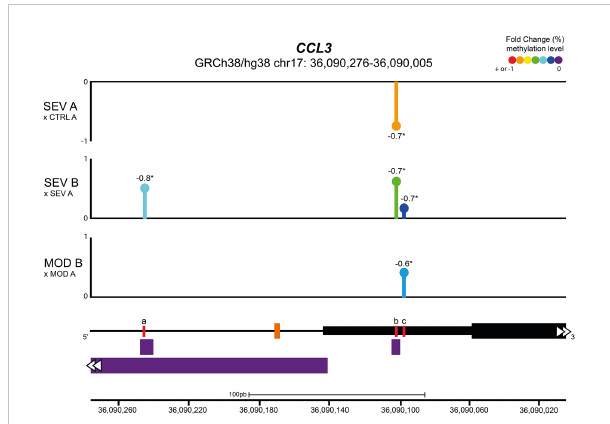
FIGURE 4 Vitamin B12 increased methylation levels of CpGs in regulatory regions of CCL3. Lollipop plot depicting the percent fold change of methylation levels of CpG sites in the promoter region and proximal portion of the fi rst exon of the CCL3 gene. Values next to lollipops represent correlation coef fi cients (Pearson or Spearman) with statistical signi fi cance (* P < 0.05) between methylation levels in each CpG position and gene expression values. The % fold change of methylation levels of CpG positions were compared pairwise using two-tailed Mann-Whitney. N sample = MOD (5) and SEV (5) for each endpoint (A or B), CTRL (5). In the schematic representation of the analyzed gene region, the black line represents the CCL3 promoter region and the black blocks delimit the 5 ’ UTR region (thin block) and proximal portion of the fi rst exon of CCL3 (thick block). The orange dash indicates the transcription start site of CCL3 and the purple blocks indicate transcription factor binding sites. Red lines correspond to differentially methylated CpG sites, coordinates (GRCh38/hg38): a = chr17: 36,090,246; b = chr17: 36,090,102; c = chr17:36,090,097. Abbreviations: SEV = severe COVID-19; MOD = moderate COVID-19; CTRL = untreated non-infected controls. Suf fi xes: A = endpoint A (samples added to culture medium with excipient and incubated for 24h); B = endpoint B (samples added to culture medium with B12 and incubated for